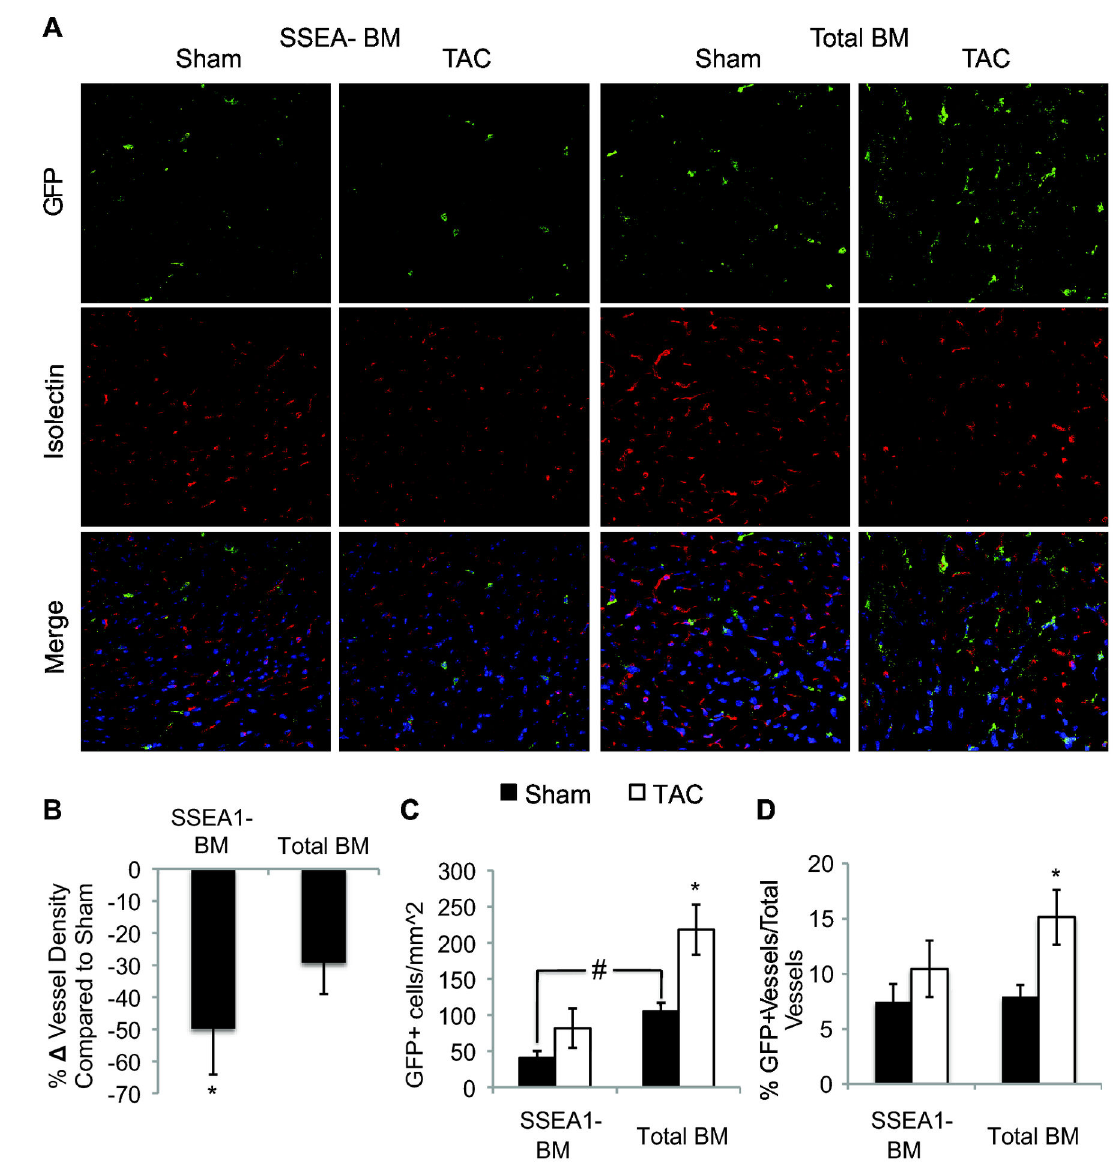
Figure 4. Depletion of SSEA1 from the Bone Marrow Increases Vessel Rarefaction after TAC. (A) Representative images used to quantify vessel density (Magnification 40x). Vessels were identified as Isolectin+ (Red) and nuclei are labeled with DAPI (blue). Representative images of GFP+ bone marrow derived (Green) alone and their co-localization with the vasculature (Isolectin, Red). Vessel density was quantified as Isolectin+/mm 2 . (B) Mice with SSEA1-BM had significantly decreased vessel density 28 days after TAC compared to sham (P = 0.03). No significant change was measured in TAC mice with total BM (P = 0.28). No differences were identified between sham animals. n = 4-6 per group. (C) Data representing the number of bone marrow derived cells (GFP+) in the myocardium in sham (black bars) and TAC (white bars) animals. In sham animals, there are significantly fewer bone marrow cells in the heart of SSEA1 depleted BM mice compared to animals with total BM. Four weeks after TAC, GFP+ cells were significantly increased in the myocardium in mice with total BM but not in SSEA1-BM mice. (D) Quantification of the percentage of total vessels that are GFP+ (bone marrow derived) in sham and TAC animals. The percentage significantly increased after TAC in mice with total BM compared to sham. No differences were measured between sham and TAC SSEA1 depleted BM mice or between sham groups. Abbreviations: SSEA1, stage-specific embryonic antigen 1; TAC, trans-aortic constriction; SSEA1 depleted BM, SSEA1+ cell depleted bone marrow; BM, bone marrow.